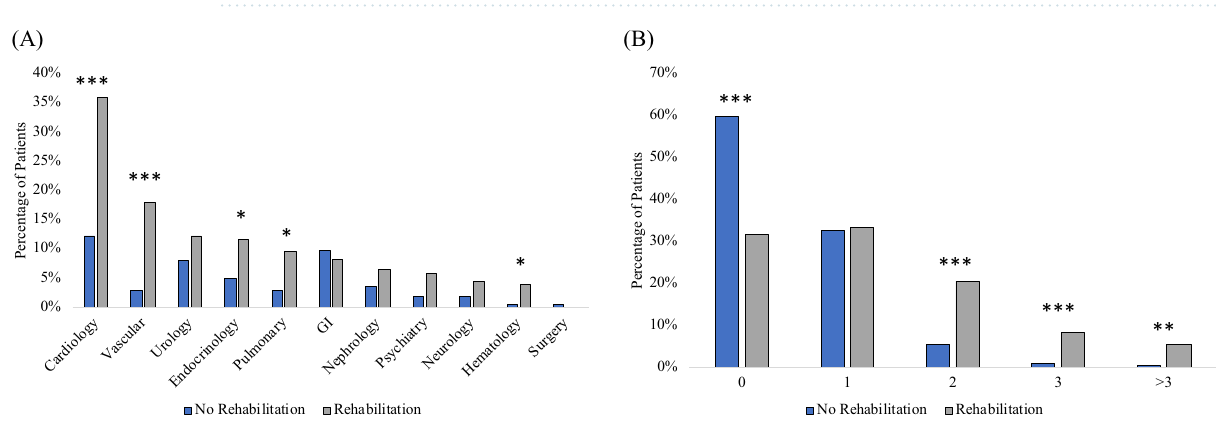
Functional scores were evaluated with respect to pre-admission dependency status and LOS. Functional scores of rehabilitation patients were below normal (Mental Status Score: 2.72 out of 3, ICU Mobility Scale: 6.87 out of 10, and modified Barthel Index Score: 45.58 out of 75, all p < 0.0001). Higher func- tional scores were found in patients who were independent pre-admission, followed by those who required partial assistance and were dependent ( p < 0.0001 for all scores, Fig. 5A). Functional scores did not depend on duration of hospitalization ( p > 0.05, Fig. 5B). were significantly negatively correlated with age, hypertension, coronary artery disease, chronic kidney disease, psychiatric disease, anemia, and neurological disorders ( p < 0.05), whereas only some mobility and mental sta- tus scores were significantly correlated ( p < 0.05). Functional scores were not significantly correlated with lung disorders, carcinoma, hyperlipidemia, gender, race, or ethnicity ( p > 0.05).